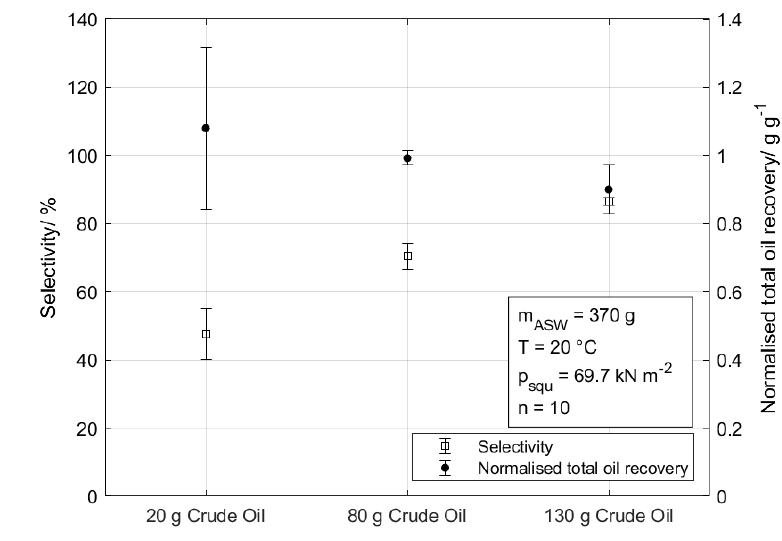
Figure 5. Oil recovery selectivity (white squares, left ordinate) according to Equation (6) and normalised total oil recovery (black circles, right ordinate) according to Equation (5) with respective standard deviations (n = 10) as a function of initially presented crude oil quantities in a basin of 370 g